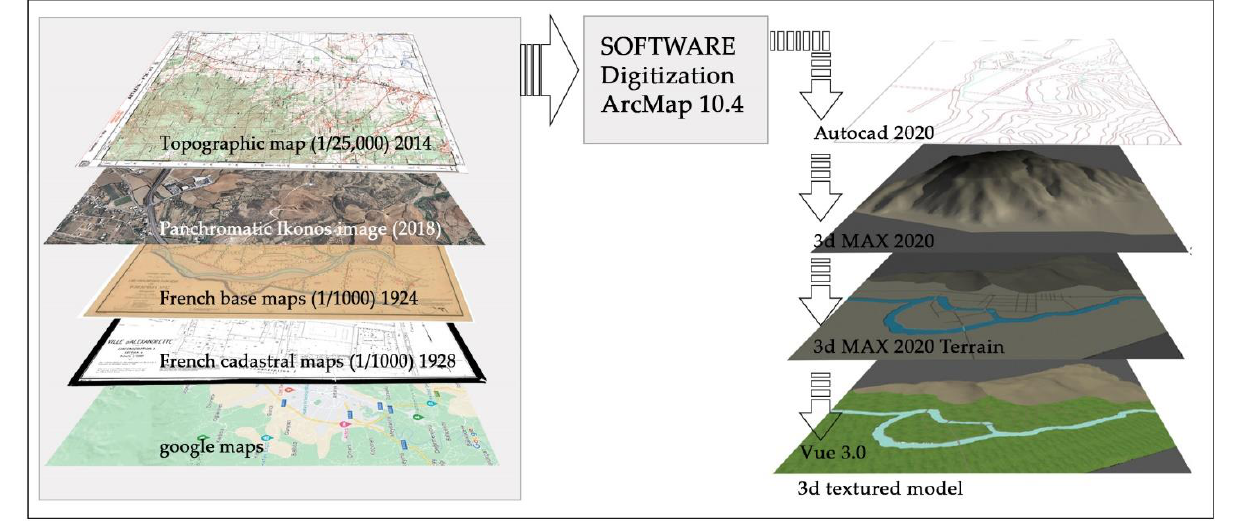
Figure 3. 3D terrain model construction stages of ancient Antioch.